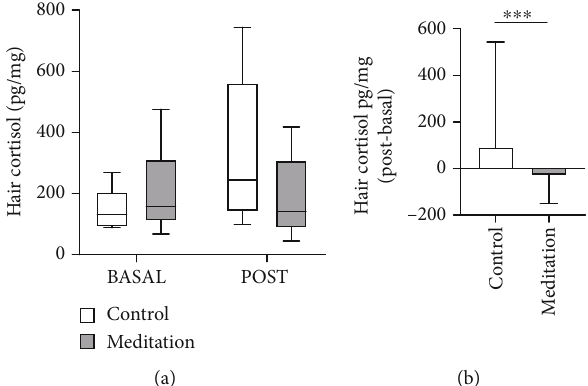
Figure 1: E ff ect of active meditation practice on hair cortisol. (a) Hair cortisol was measured in basal conditions and after a 3-month meditation intervention (POST). (b) Individual hair cortisol di ff erences between posttreatment and basal values. Data represent median ± range ; Mann – Whitney test was performed; ∗∗∗ p = 0 : 0003